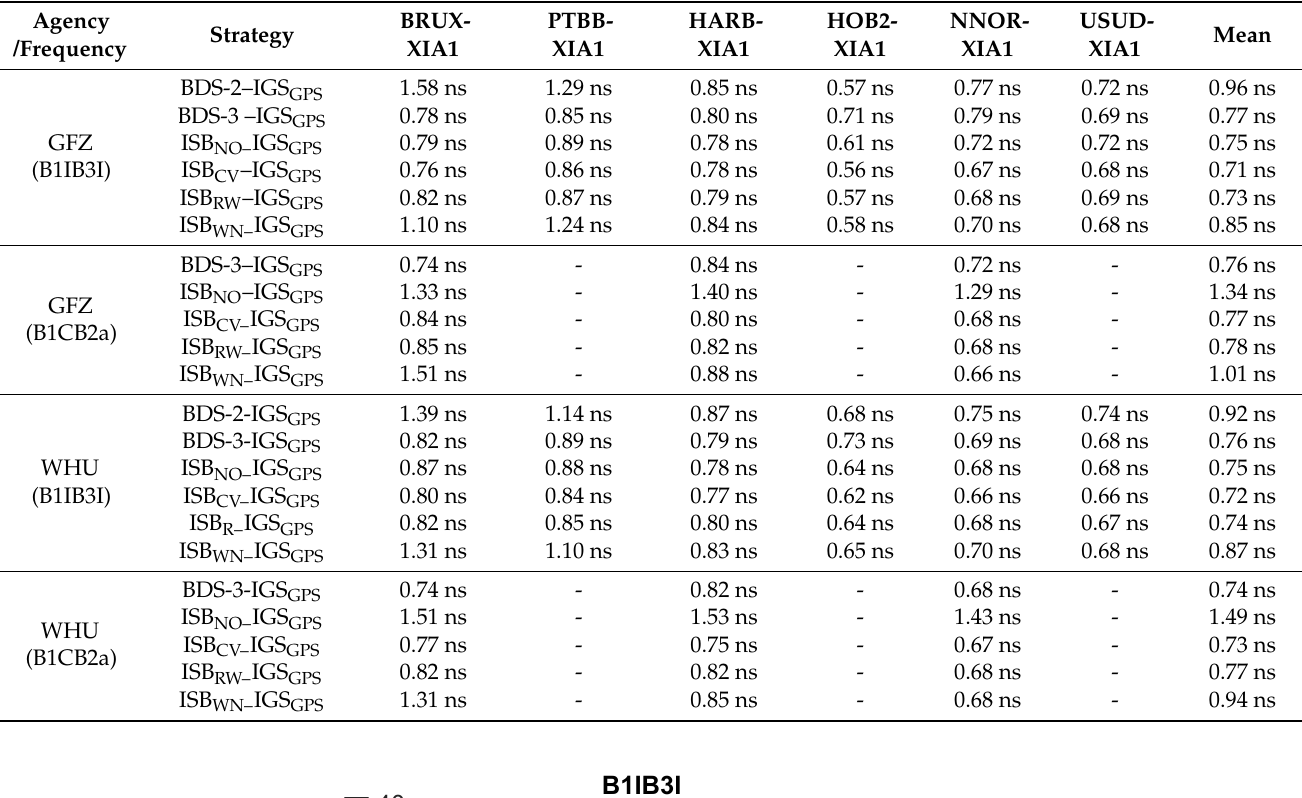
Table 7. The STD of the differences between BDS clock differences and GPS clock differences of the IGS final product from DOY 101 to 130.